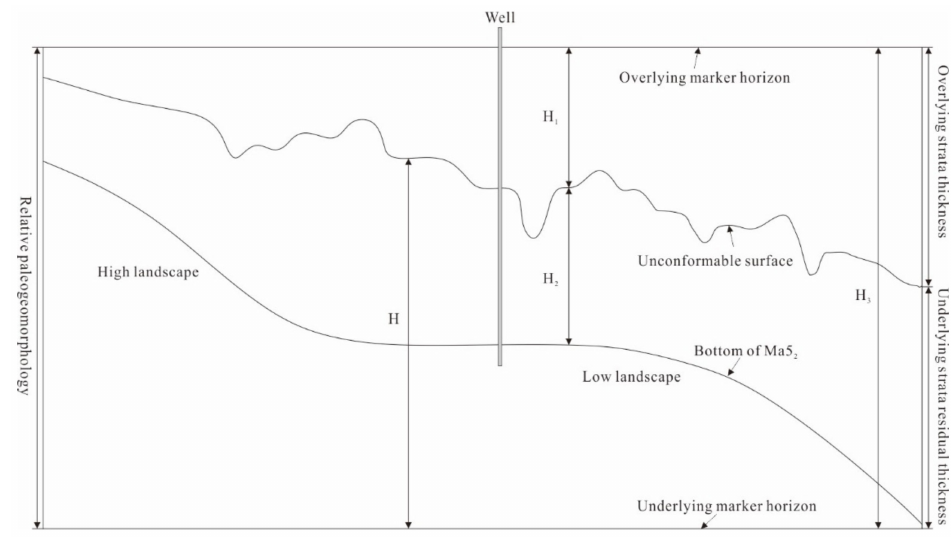
Figure 6. Geomorphology division principle for dual-interface method.